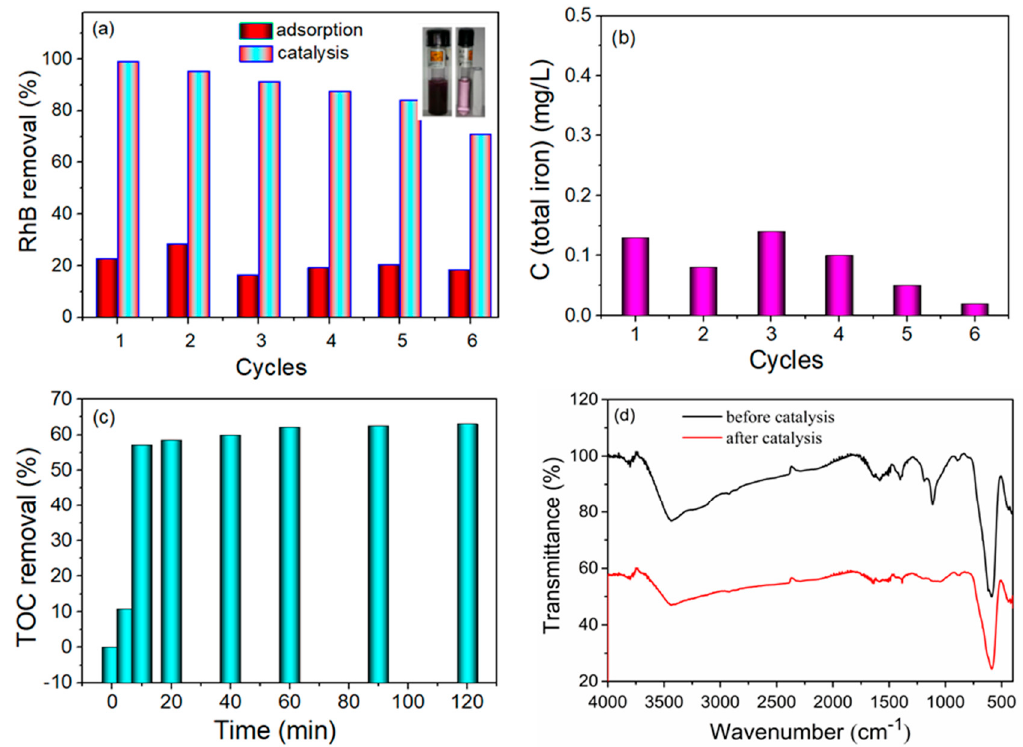
Figure 4. Adsorption–degradation cycles of ( a ) RhB, ( b ) total iron leaching, ( c ) total organic carbon (TOC) removal, and ( d ) the FTIR spectra of Fe 3 O 4 @GO before and after RhB degradation.